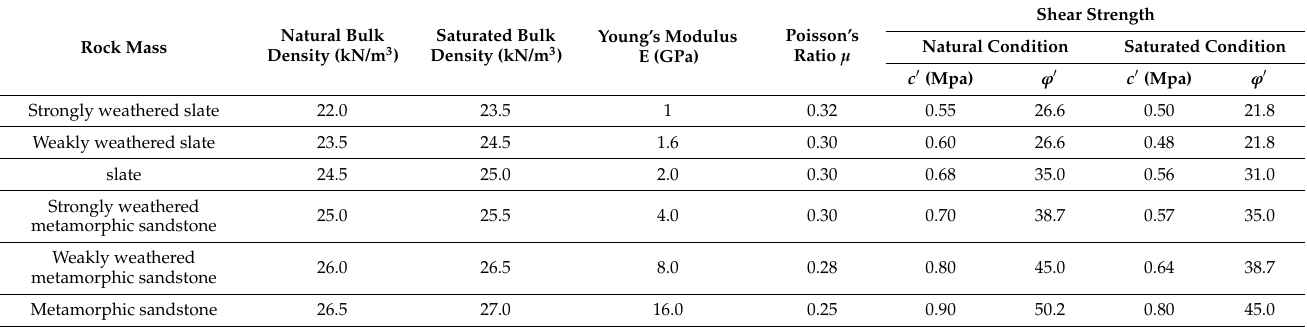
Table 1. The physical and mechanical parameters of rock